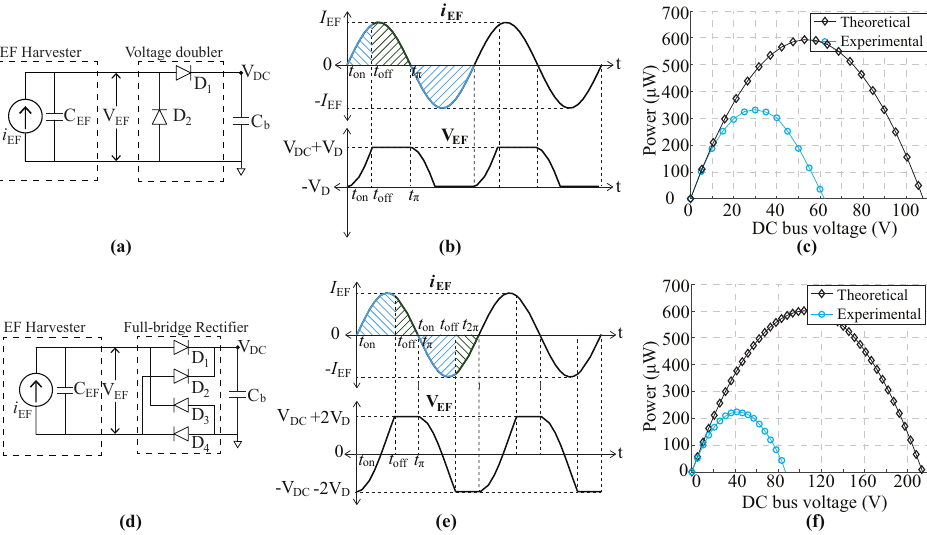
Figure 3. Main management circuits. ( a ) Voltage-doubler circuit; ( b ) current and voltage waveforms for a voltage-doubler circuit; ( c ) theoretical, simulated, and experimental output power considering a voltage doubler; ( d ) full bridge rectifier circuit; ( e ) current and voltage waveforms for a full bridge rectifier circuit; ( f ) theoretical, simulated, and experimental output power considering a full bridge